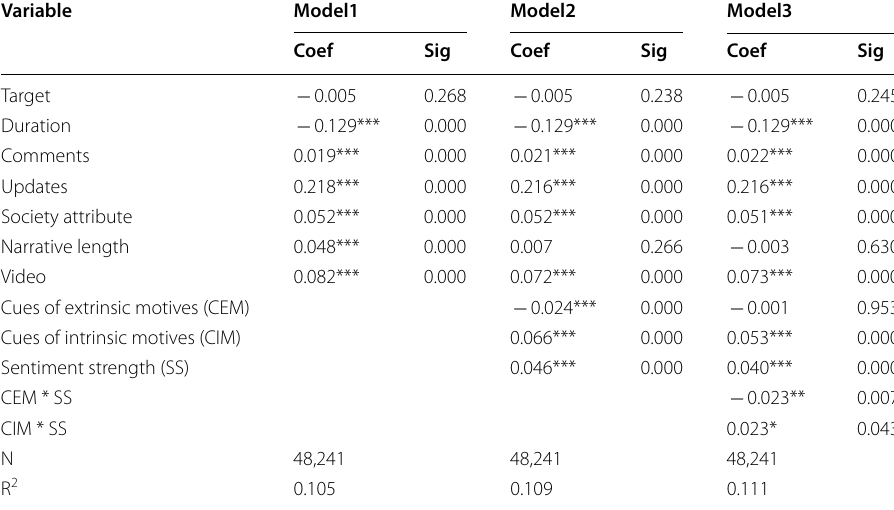
Table 10 Robust check of sentiment strength model